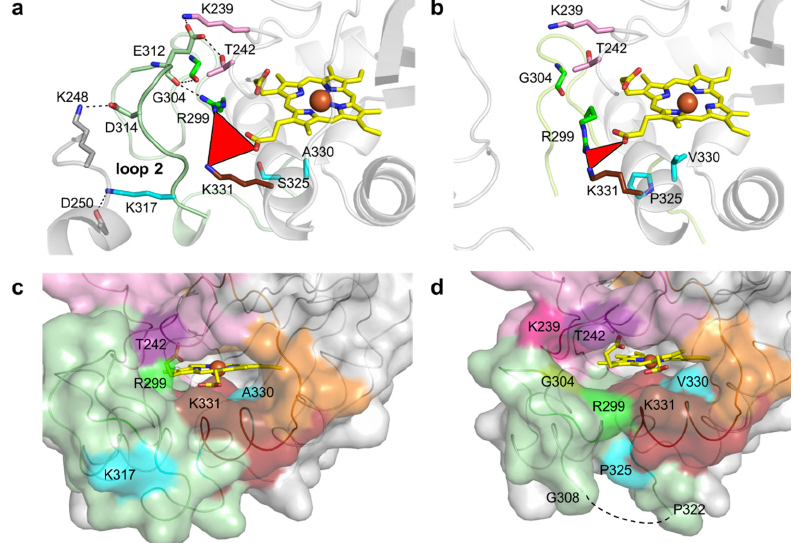
Figure 4. Residues surrounding the heme cavity in Bs DyP wild type and 5G5. Stick representation of residues limiting the access to heme cavity and interacting with residues K317, D314 and E312 of loop 2 in wild type ( a ) and 5G5 variant ( b ). The carbon atoms of the mutated residues (S325P, A330V and K317E) are colored in cyan. The residues K239 and T242 (loop 1) and R299 and G304 (loop 2) are interacting through hydrogen bonds with E312 (loop 2) and are colored accordingly (Figure 3). The residues of the symmetry-related molecule K248 and D250 are represented with carbon atoms colored in gray. The hydrogen bonds between residues are shown as dashed lines. The red triangle represents the interatomic distances between R299, K331 and the heme propionate group. Solvent-accessible surface area (ASA) representation of the regions delimiting the cavity is colored as in Figure 3 for wild type ( c ) and 5G5 ( d ). The residues with higher ASA values (K239, T242, R299, G304 and K331) in 5G5 are highlighted. The mutated residues K317, P325 and A/V330 are colored as in ( a ) and ( b ). The missing region 309–321 is shown as a dashed line in ( d ).